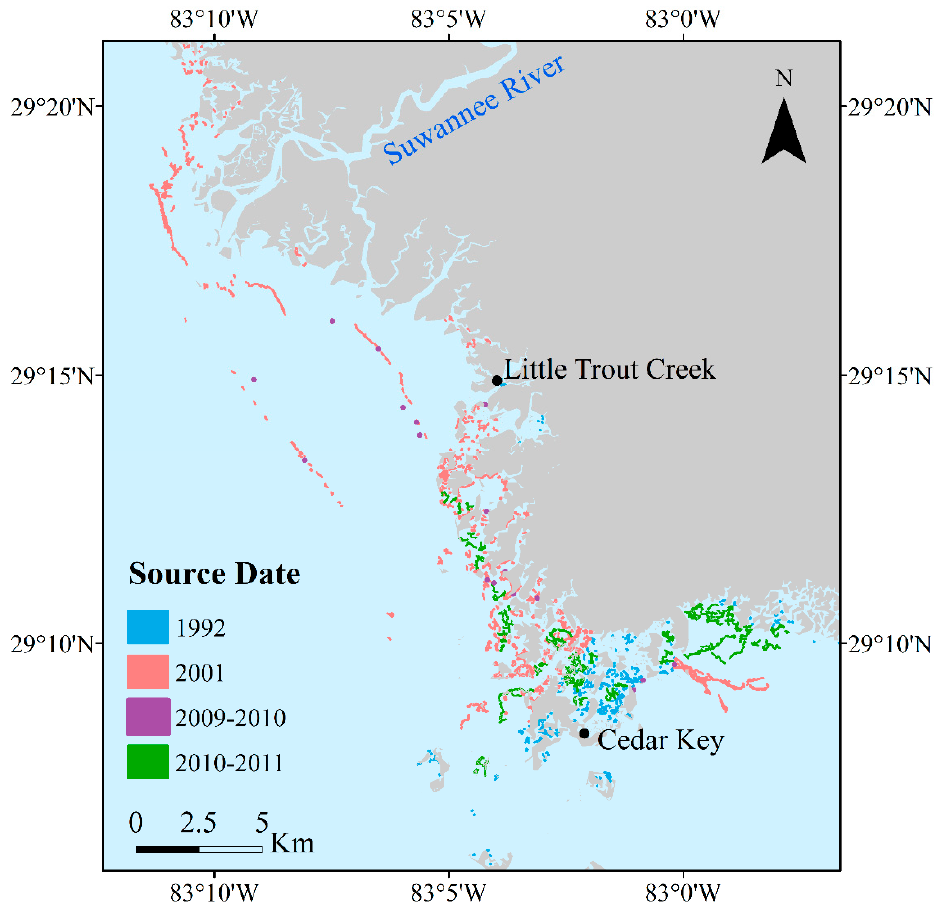
Figure 2. This historical footprint of eastern oyster reefs near Cedar Key, Florida, USA is the most comprehensive oyster reef map available of the area. Reefs are not represented to scale.